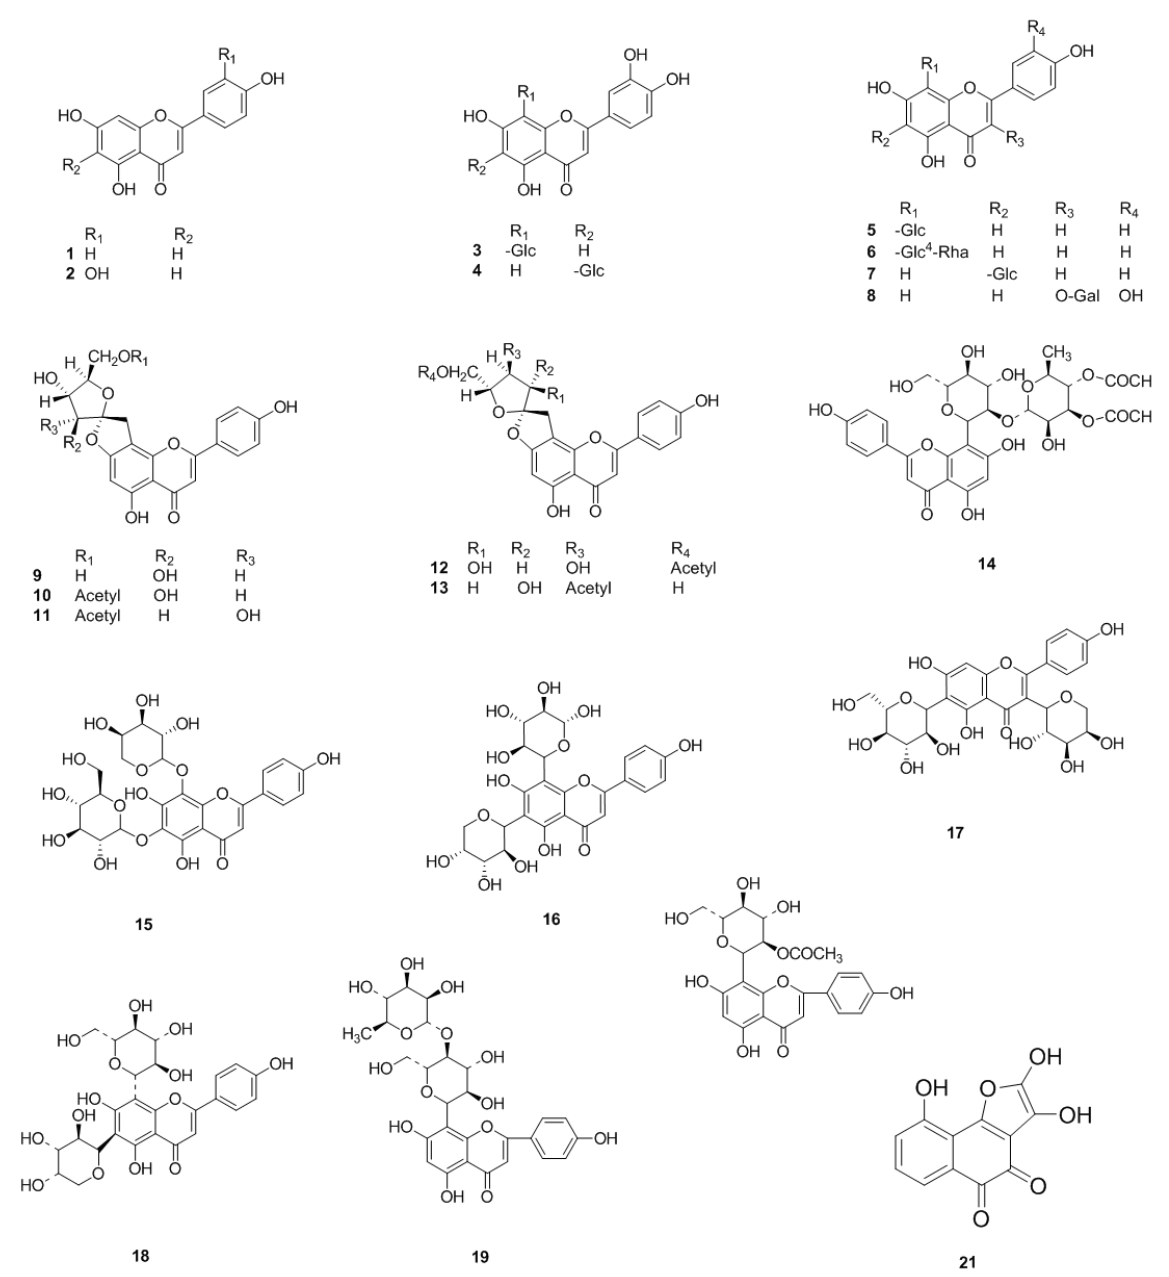
Figure 1. Chemical structures of flavones in C. pinnatifida